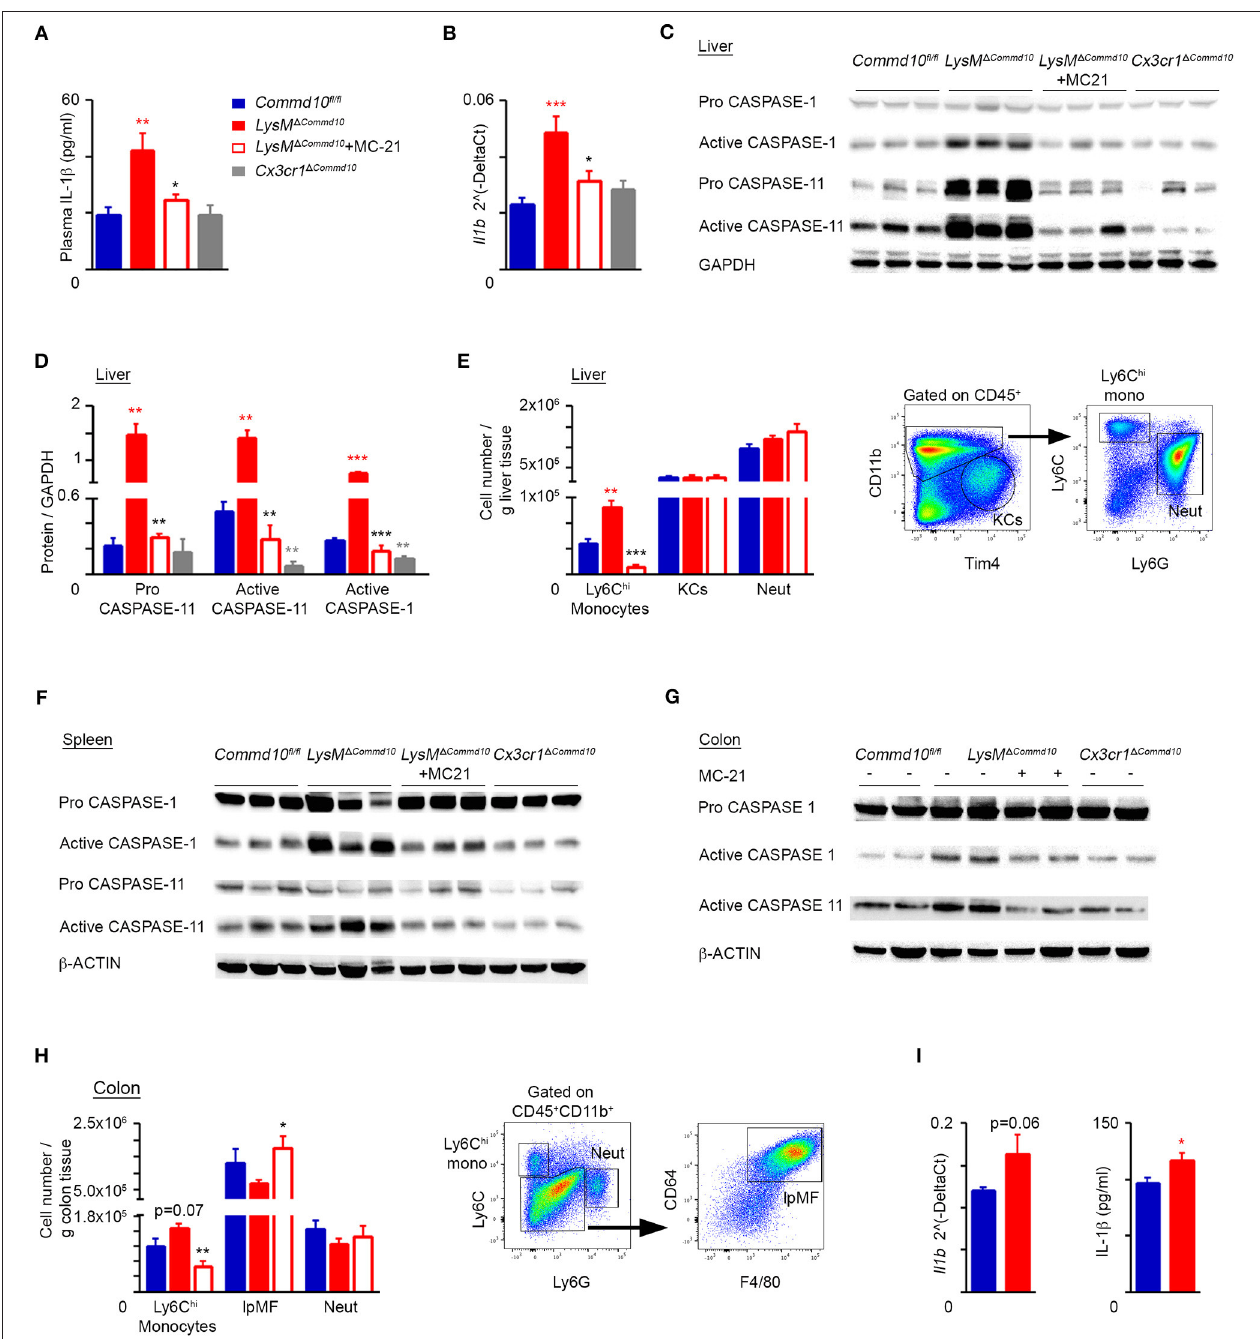
FIGURE 3 | Increased canonical and non-canonical inflammasome activity in COMMD10-deficient Ly6C hi monocytes during LPS-induced systemic inflammation. (A–H) Commd10 fl / fl (blue), LysM 1 Commd 10 (red) or Cx3cr1 1 Commd 10 (gray) mice were i.p. injected with LPS (0.2mg per mouse of similar body mass) and sacrificed 4h later. Where indicated, MC-21 was injected 12h prior to LPS stimulation (red border). (A) ELISA analysis of plasma IL-1 β ( n ≥ 5). (B) qRT-PCR gene expression of Il1b in liver extracts ( n ≥ 5). (C) Immunoblots of liver lysates demonstrating the expression of pro- and active- caspase-1 and − 11. GAPDH was utilized as control ( n = 3). (D) Respective densitometry-based quantification of pro-caspase-11, active caspase-1 and active caspase-11, normalized to GAPDH. (E) Left panel: flow cytometry-based assessment of liver Ly6C hi monocyte, KC and neutrophil abundance normalized to tissue mass (g) ( n = 5). Right panel: representative flow cytometry images showing gating strategy of liver Ly6C hi monocytes, KCs and neutrophils ( n = 5). (F,G) Immunoblots of (F) spleen and (G) colon lysates demonstrating the expression of pro- and/or active- caspase-1 and − 11. β -actin was utilized as control ( n = 3 for E , n = 2 for F ). (H) Left panel: flow cytometry-based assessment of colonic Ly6C hi monocyte, resident lpMF and neutrophil abundance normalized to tissue mass (g) ( n = 5). Right panel: representative flow cytometry